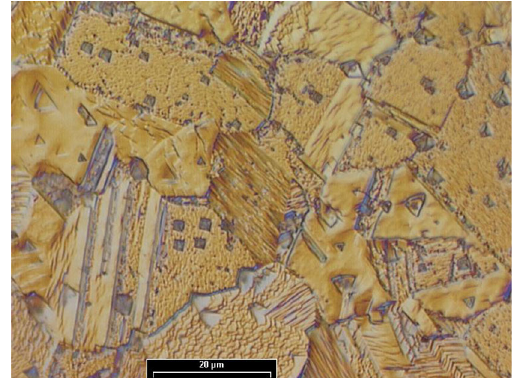
FIG. 40. Microstructure of Cu0.15%Zr after annealing at 800 °C for 2 hours.